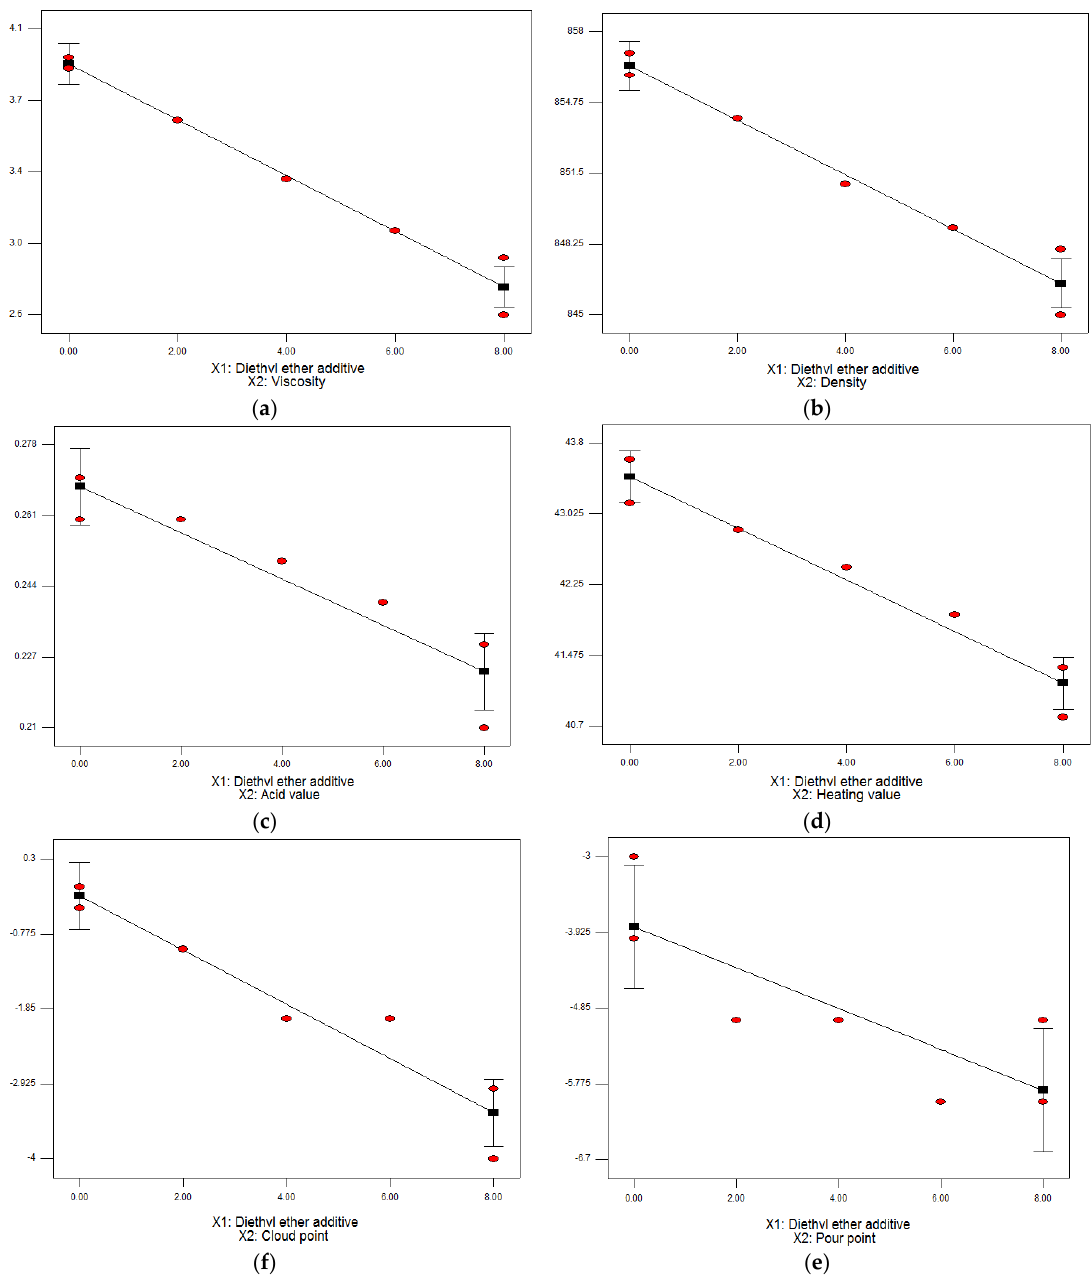
Figure 14. The optimum diethyl ether additivevalue for different fuel properties. ( a ) Viscosity; ( b ) density; ( c ) acid value; ( d ) heating value; ( e ) pour point; and ( f ) cloud point.